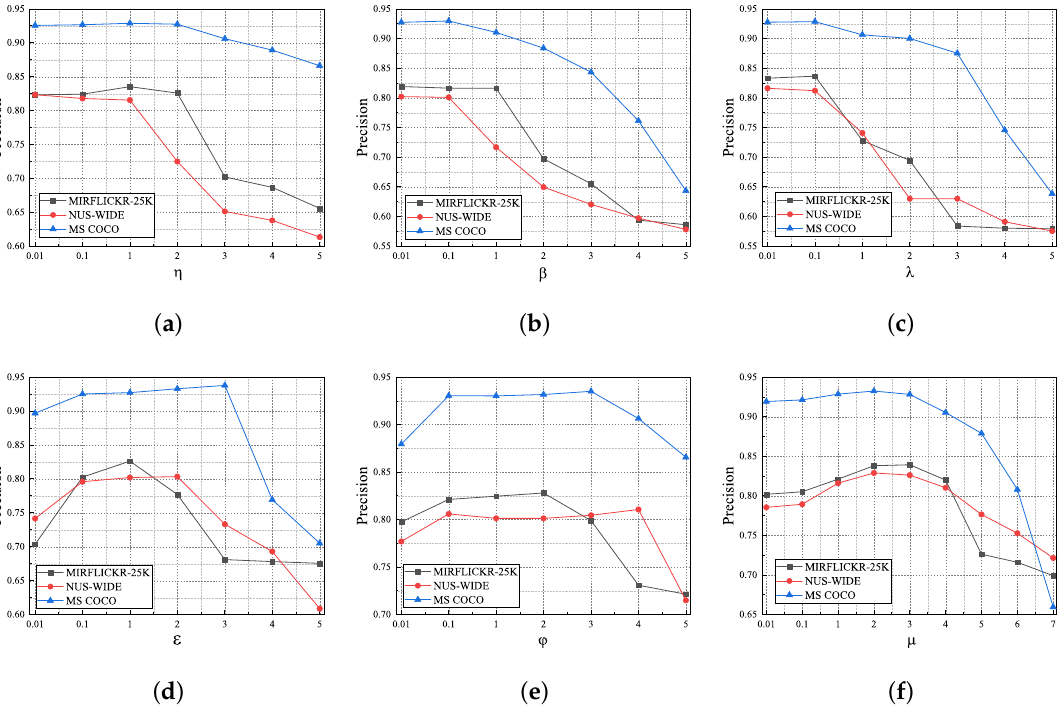
Figure 5. The parameter sensitivity analysis for η , β , λ , ε , ϕ , µ on three benchmark datasets at 128 bits. ( a ) indicates the change in model precision as the image similarity weights increase. ( b ) represents the change in retrieval precision as the text similarity weights increase. ( c ) λ is a trade-off parameter for cross-modal similarity. ( d ) ε weighs the contribution of intra-modal loss. ( e ) ϕ weighs the contribution of the auxiliary GCN loss. ( f ) µ is a scale hyper-parameter that can regulate the quantization scope for the similarity